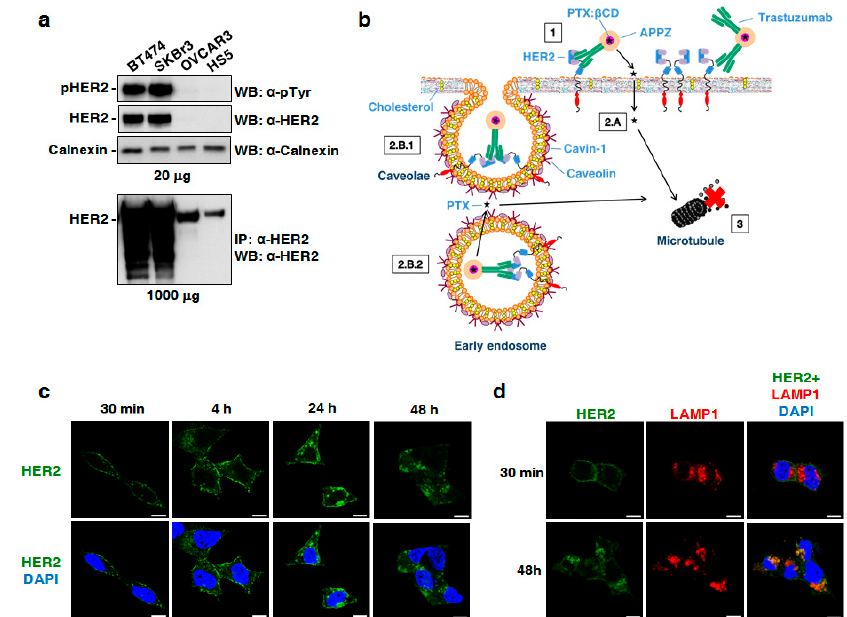
Figure 3. Conjugated APPZ internalization in BT474 cells. ( a ) Study of the HER2 and pHER2 expression levels in the BT474, SKBR3, OVCAR3, and HS5 cell lines. Calnexin was employed as loading control. ( b ) Expected conjugated APPZ internalization into HER2-overexpressing cancer cells. ( c ) HER2 internalization into BT474 cells’ cytoplasm after treatment with conjugated APPZ. Scale bar, 10 µ m. ( d ) Co-localization (orange) between HER2 and LAMP1 staining after conjugated APPZ treatment. Scale bar, 10 μ m.